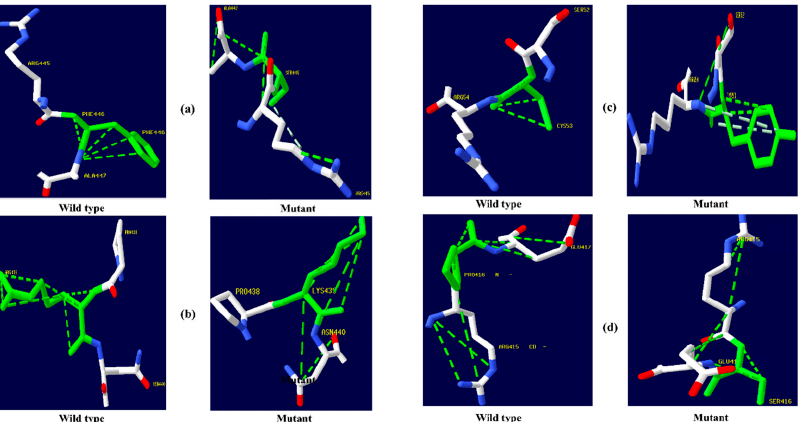
− 1.871 Table 6. Prediction of relative surface accessibility of NR3C1 through NetsurfP. Gene